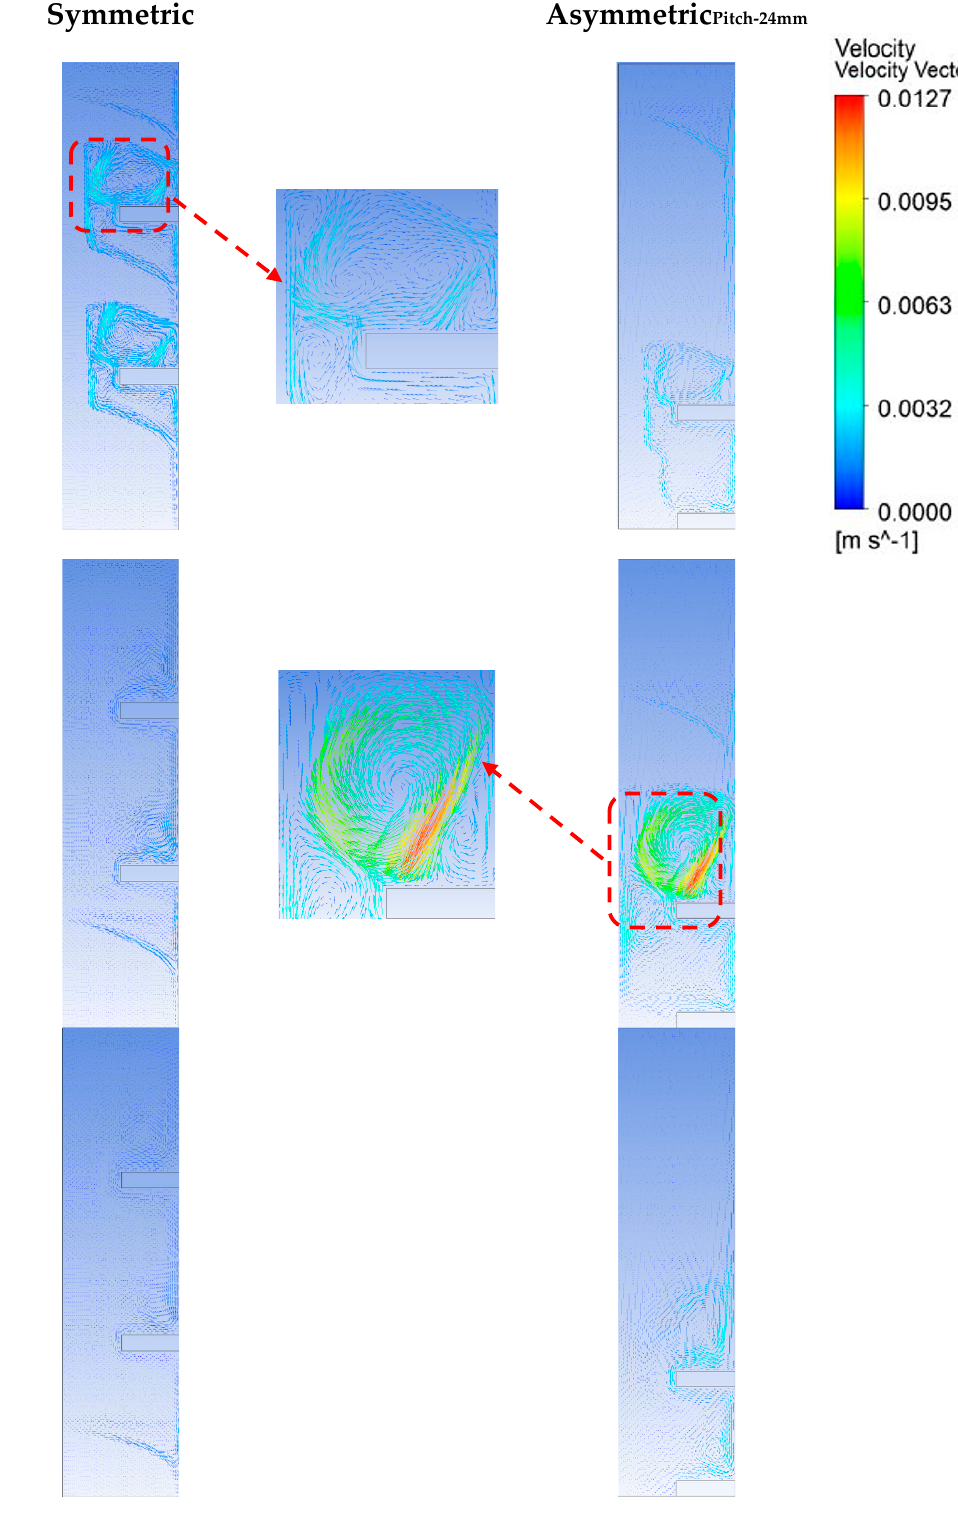
Figure 13. Velocity vectors for symmetric and asymmetric fin configurations (pitch − 24 mm).